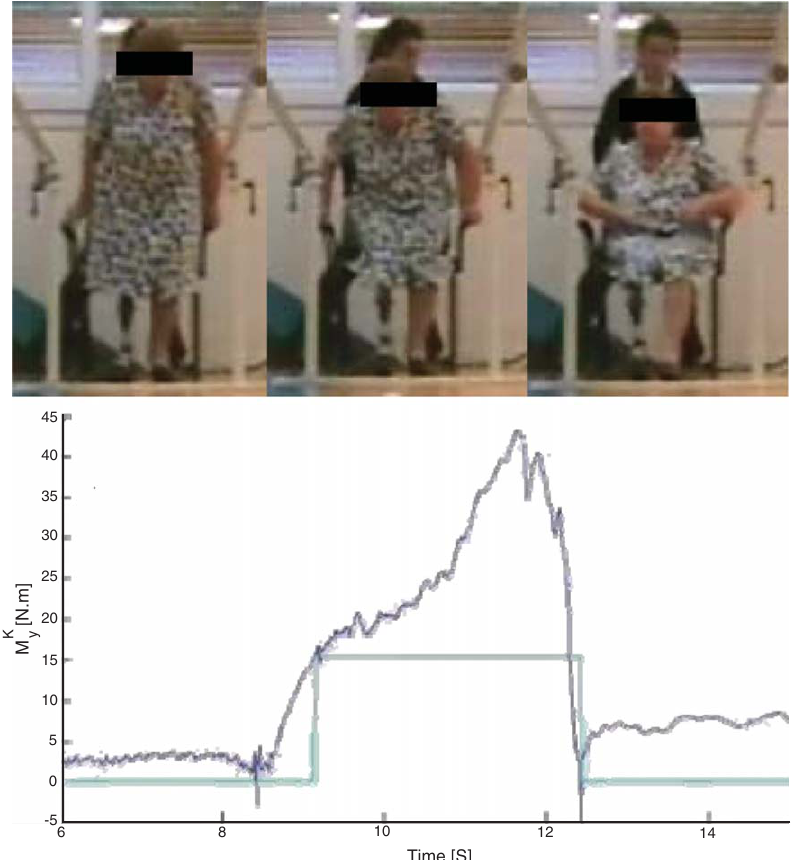
Fig. 12. Stand-to-sit task performed by an amputee patient wearing our prosthesis. Top: Pictures from video recording – Bottom: Knee moment evolution in dark blue.